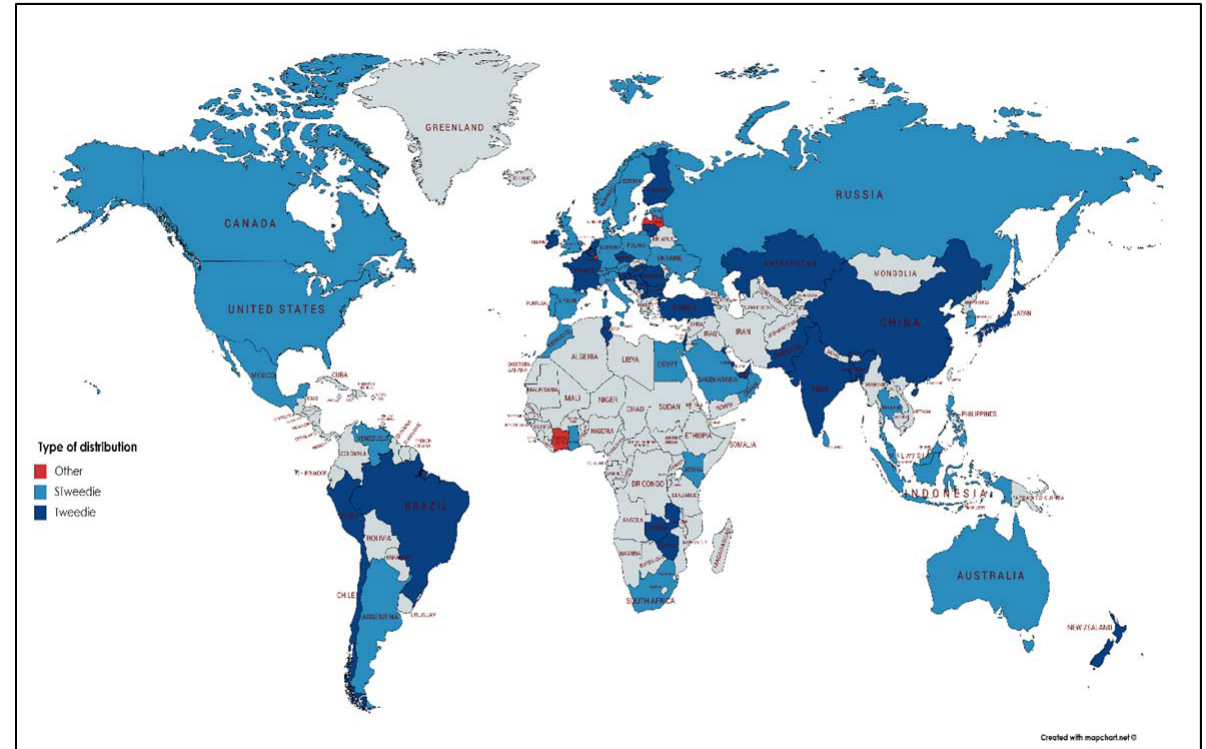
Figure 5 : Dividend Payout Ratio’s Type of Distribution across